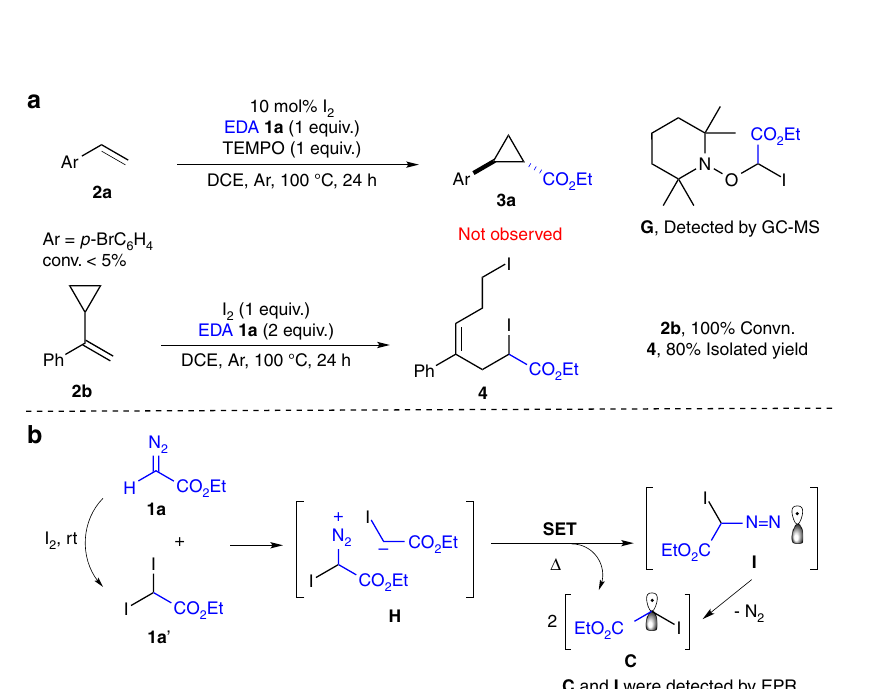
Fig. 4 Evidences for radical process under thermal condition. a Radical trapping and radical clock experiments. b Proposed mechanism for the generation of intermediate